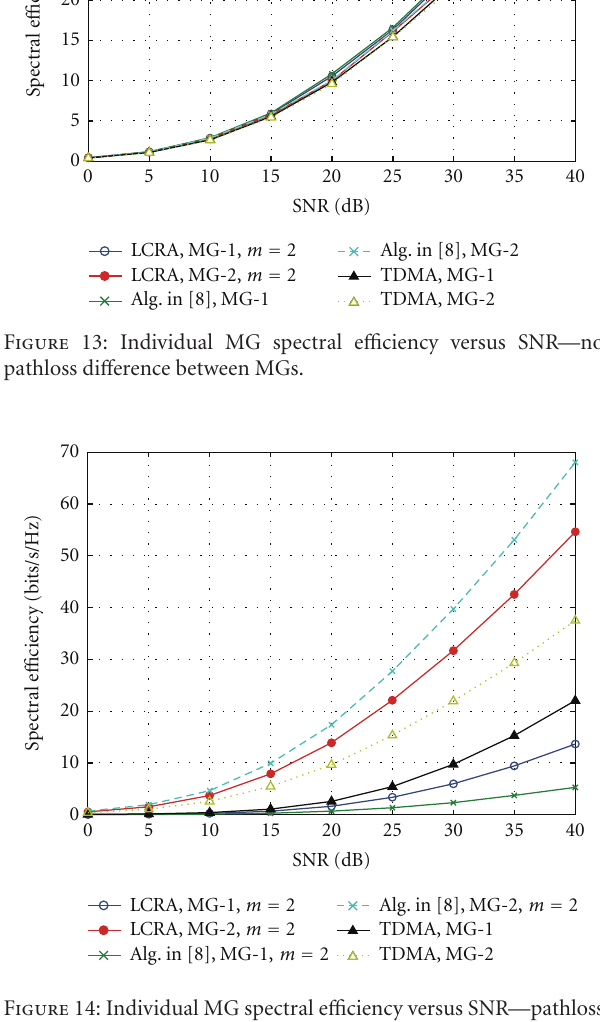
Figure 14: Individual MG spectral e ffi ciency versus SNR—pathloss di ff erence between